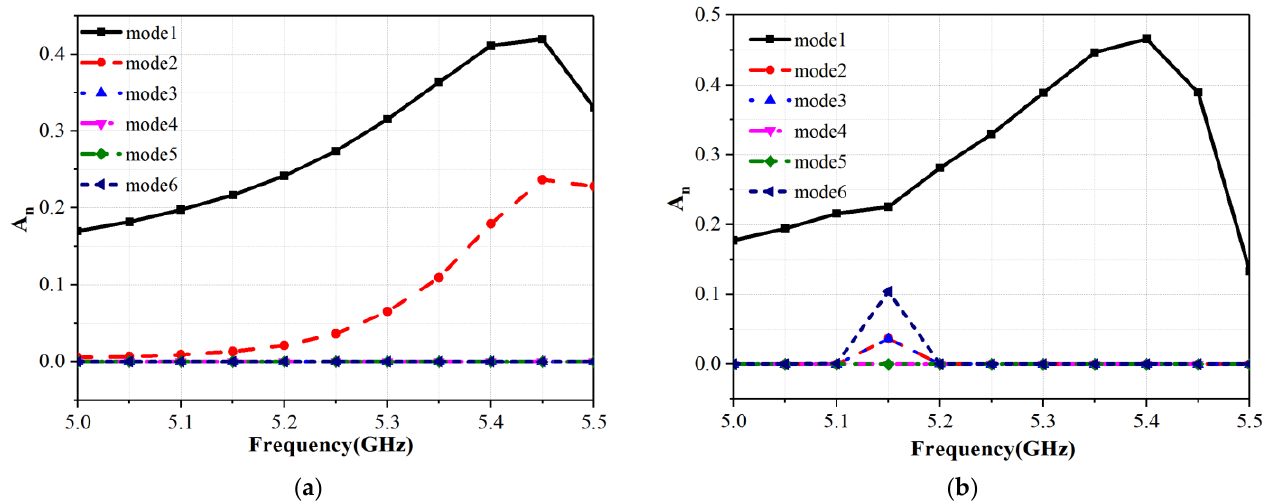
Figure 4. 𝐴 𝑛 of the radiation characteristic modes of the reference antenna and antenna A. ( a ) Reference antenna; ( b ) antenna A.